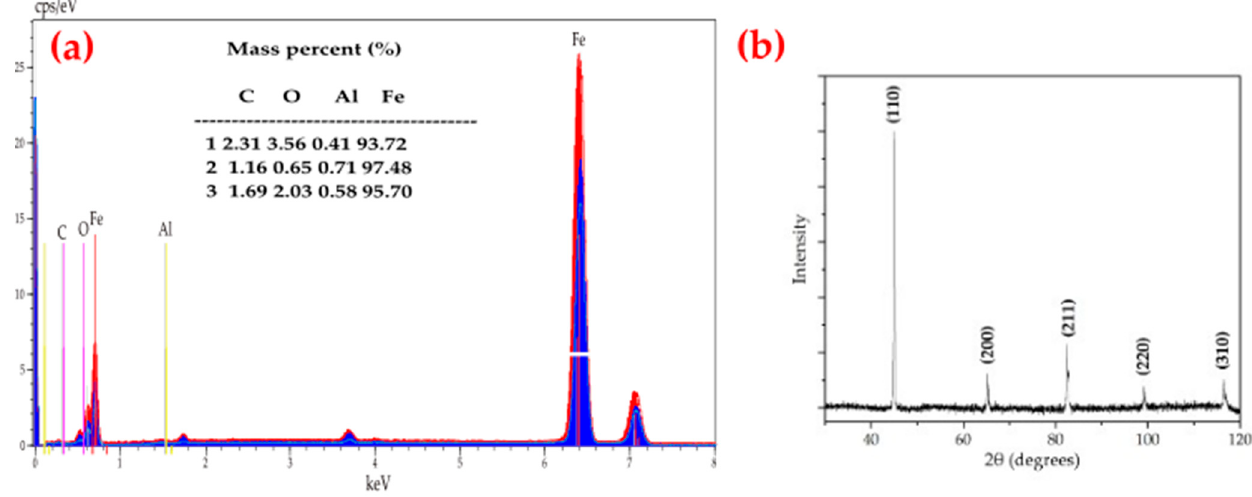
Figure 3. Energy dispersive spectroscopy (EDS) spectrum of synthesized Fe scaffolds ( a ) and their XRD diffraction characteristics ( b ).